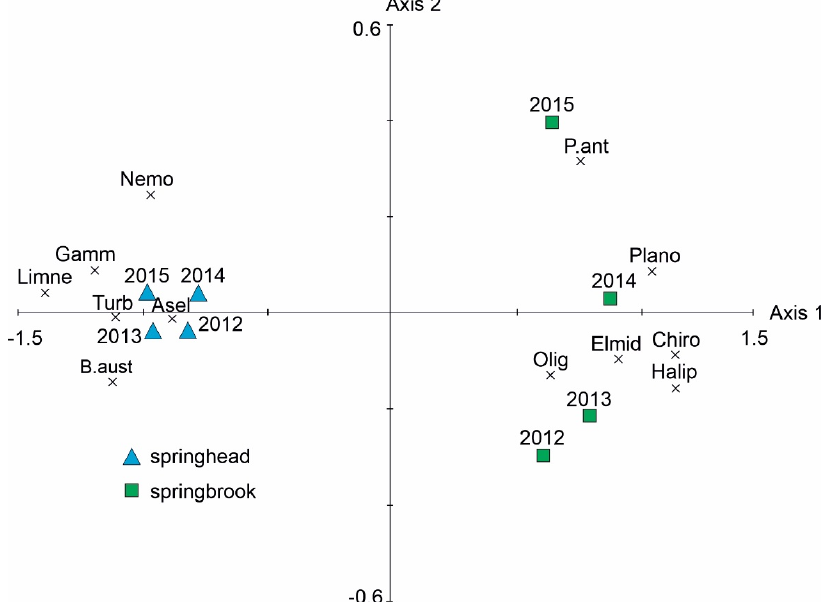
Figure 3. Non-metric multidimensional scaling (NMDS) ordination of the macroinvertebrate taxa at the studied spring ecosystem. Taxa codes: Asel—Asellidae, B.aust— Bythinella cf. austriaca , Chiro— Chironomidae, Elmid—Elmidae, Gamm—Gammaridae, Halip—Haliplidae, Limne—Limne- philidae, Nemo—Nemouridae, Olig—Oligochaeta, Plano—Planorbidae, P.ant— Potamopyrgus antip- odarum , Turb—Turbellaria.